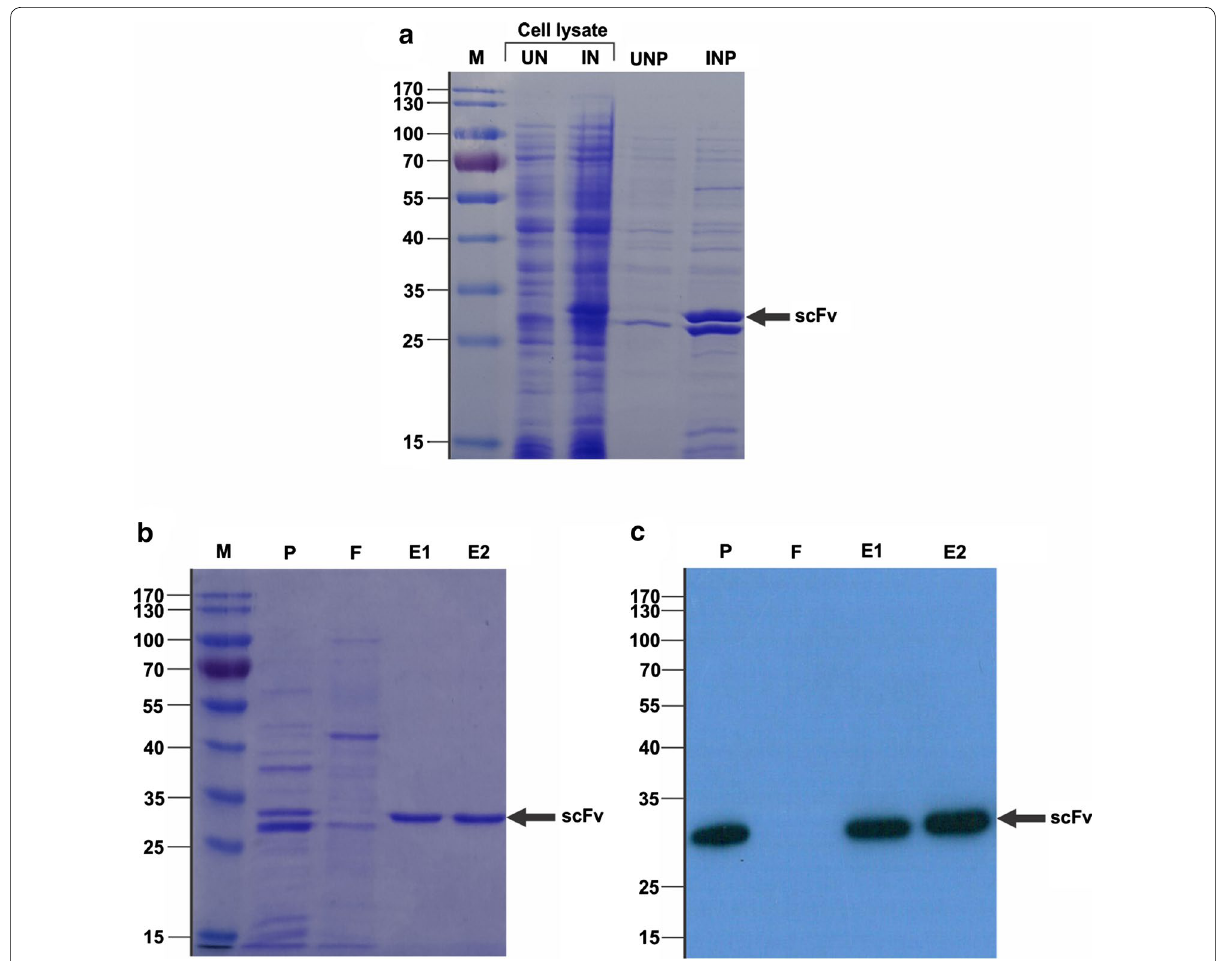
Fig. 1 Expression and purification analysis. a Shows a sodium dodecyl sulfate–polyacrylamide gel (SDS PAGE) analysis to confirm the expression − of anti-G17-Gly. The identical amount of samples including UN, uninduced total cell lysate; IN, induced total cell lysate; UNP, uninduced periplasm fraction; and INP, induced periplasmic fraction were separated on 12% SDS-PAGE and then stained with Coomassie Brilliant Blue R250. b , c Show confirmation of the purification process by 12% SDS-PAGE and immunoblotting, respectively. The blots were probed by anti ‐ c ‐ myc mAb (9E10) and horseradish peroxidase (HRP) ‐ conjugated goat anti ‐ mouse IgG, consecutively. The protein bands were appeared on X ‐ ray film by incubation with ECL substrate. The arrowheads denote the approximate molecular weight of the scFvs (around 28 kDa). M Molecular weight standards in kDa, P periplasmic extraction, F flow ‐ through, E1 and E2 eluted